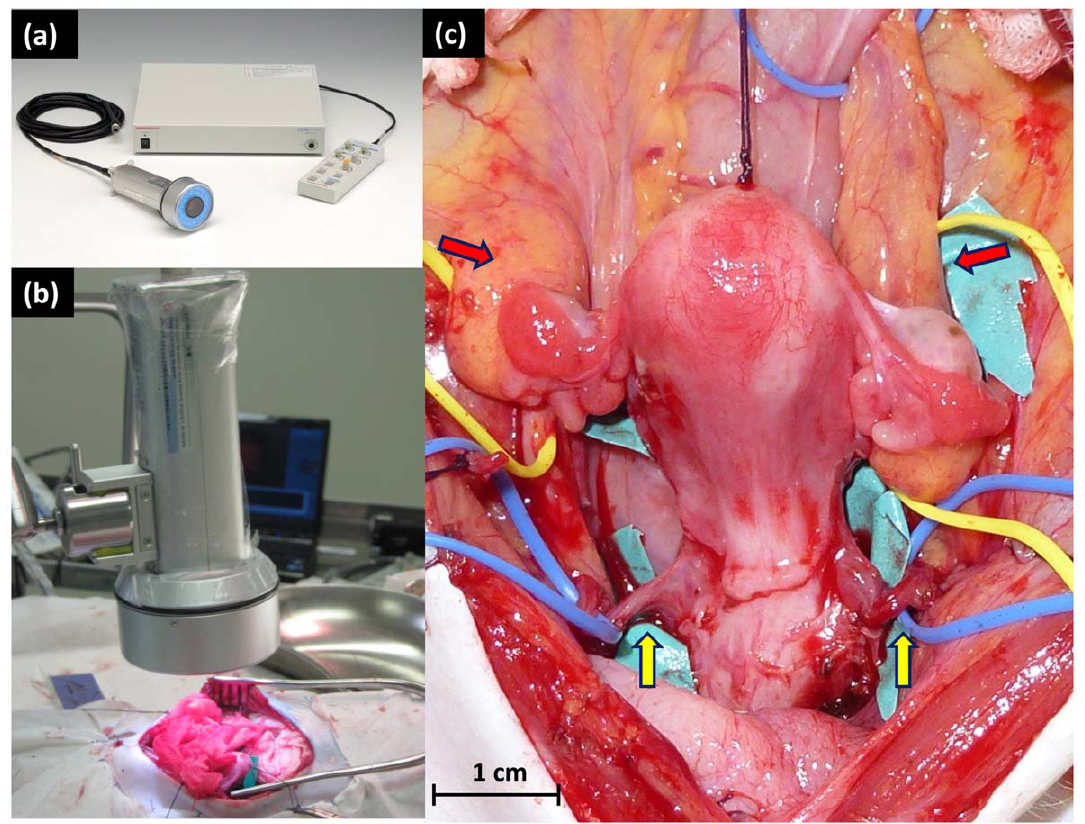
Figure 1. Preparation for intraoperative observation of uterine hemodynamics with ICG fluorescence imaging. (a) The ICG fluorescence imaging system, including the main body, camera unit, and remote controller. (b) CCD camera unit of a PDE installed at the site of surgery. (c) The uterus with a separated vaginal canal. The uterus was connected by the uterine artery/vein (yellow arrow) and ovarian artery/vein (red arrow).